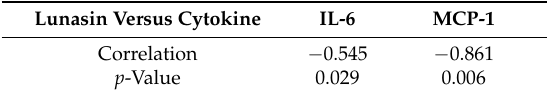
Figure 4. Effect of lunasin on interleukin (IL)-6 and macrophage chemoattractant protein (MCP)-1 secretion in 3T3-L1 adipocytes stimulated by tumor necrosis factor (TNF)- α . ( a ) Inflammatory activation of 3T3-L1 adipocytes was achieved by stimulation with TNF- α , and cells were treated with lunasin at the same time for 24 h; ( b ) IL-6 and MCP-1 production in supernatant was measured by ELISA; Correlation of lunasin dosage and cytokine quantity is presented in the Table 1. Data are shown as mean ± SEM. Statistical analysis was tested by one-way ANOVA and then Fisher’s LSD test; significant differences are presented as * p < 0.05 or & p < 0.005 versus control group. Table 1. Correlation of lunasin dosage and cytokine quantity .